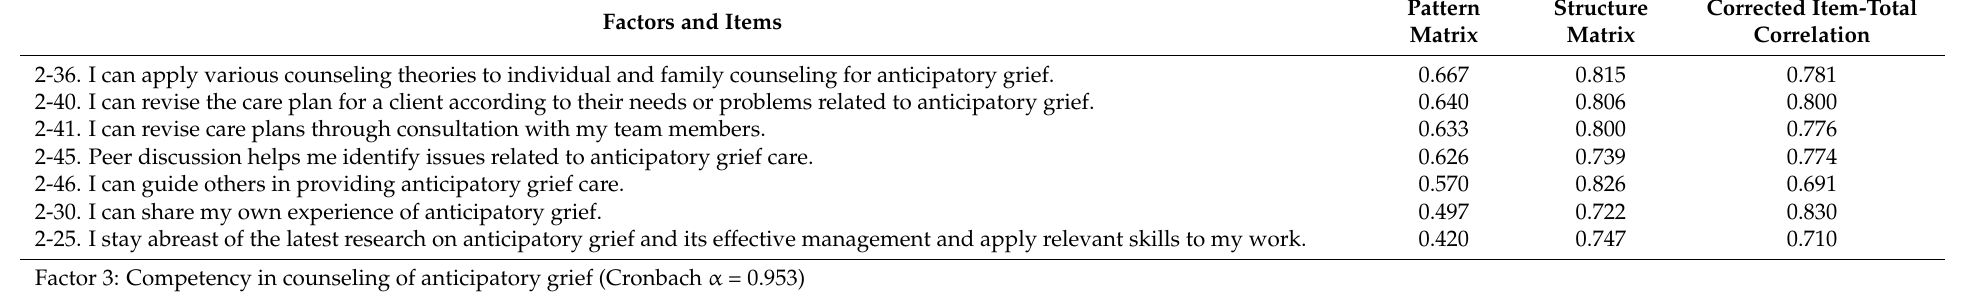
Factors and Items